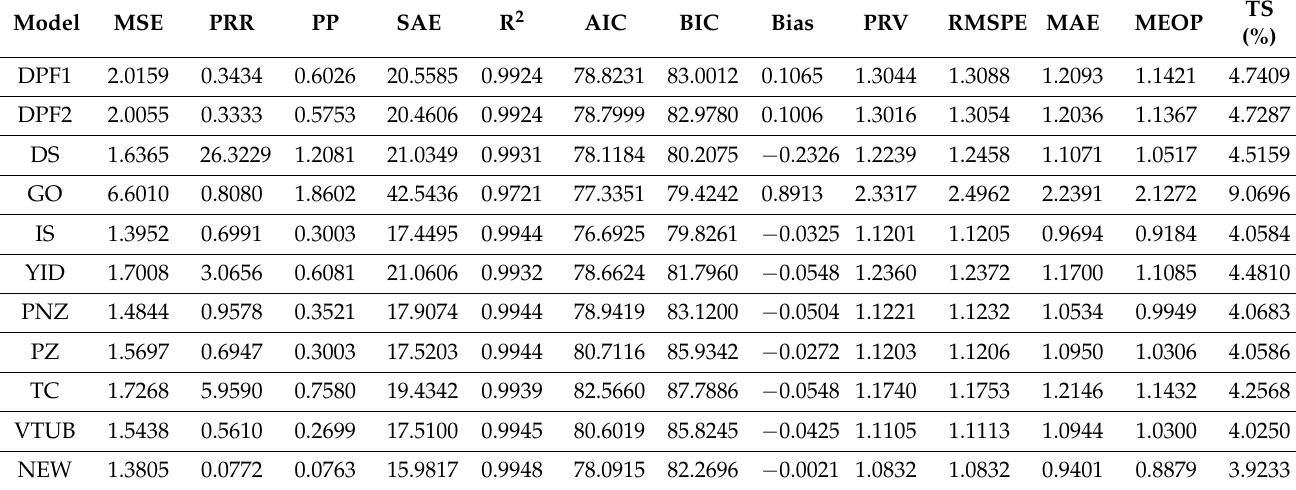
Table 7. Criteria values for model comparison of dataset